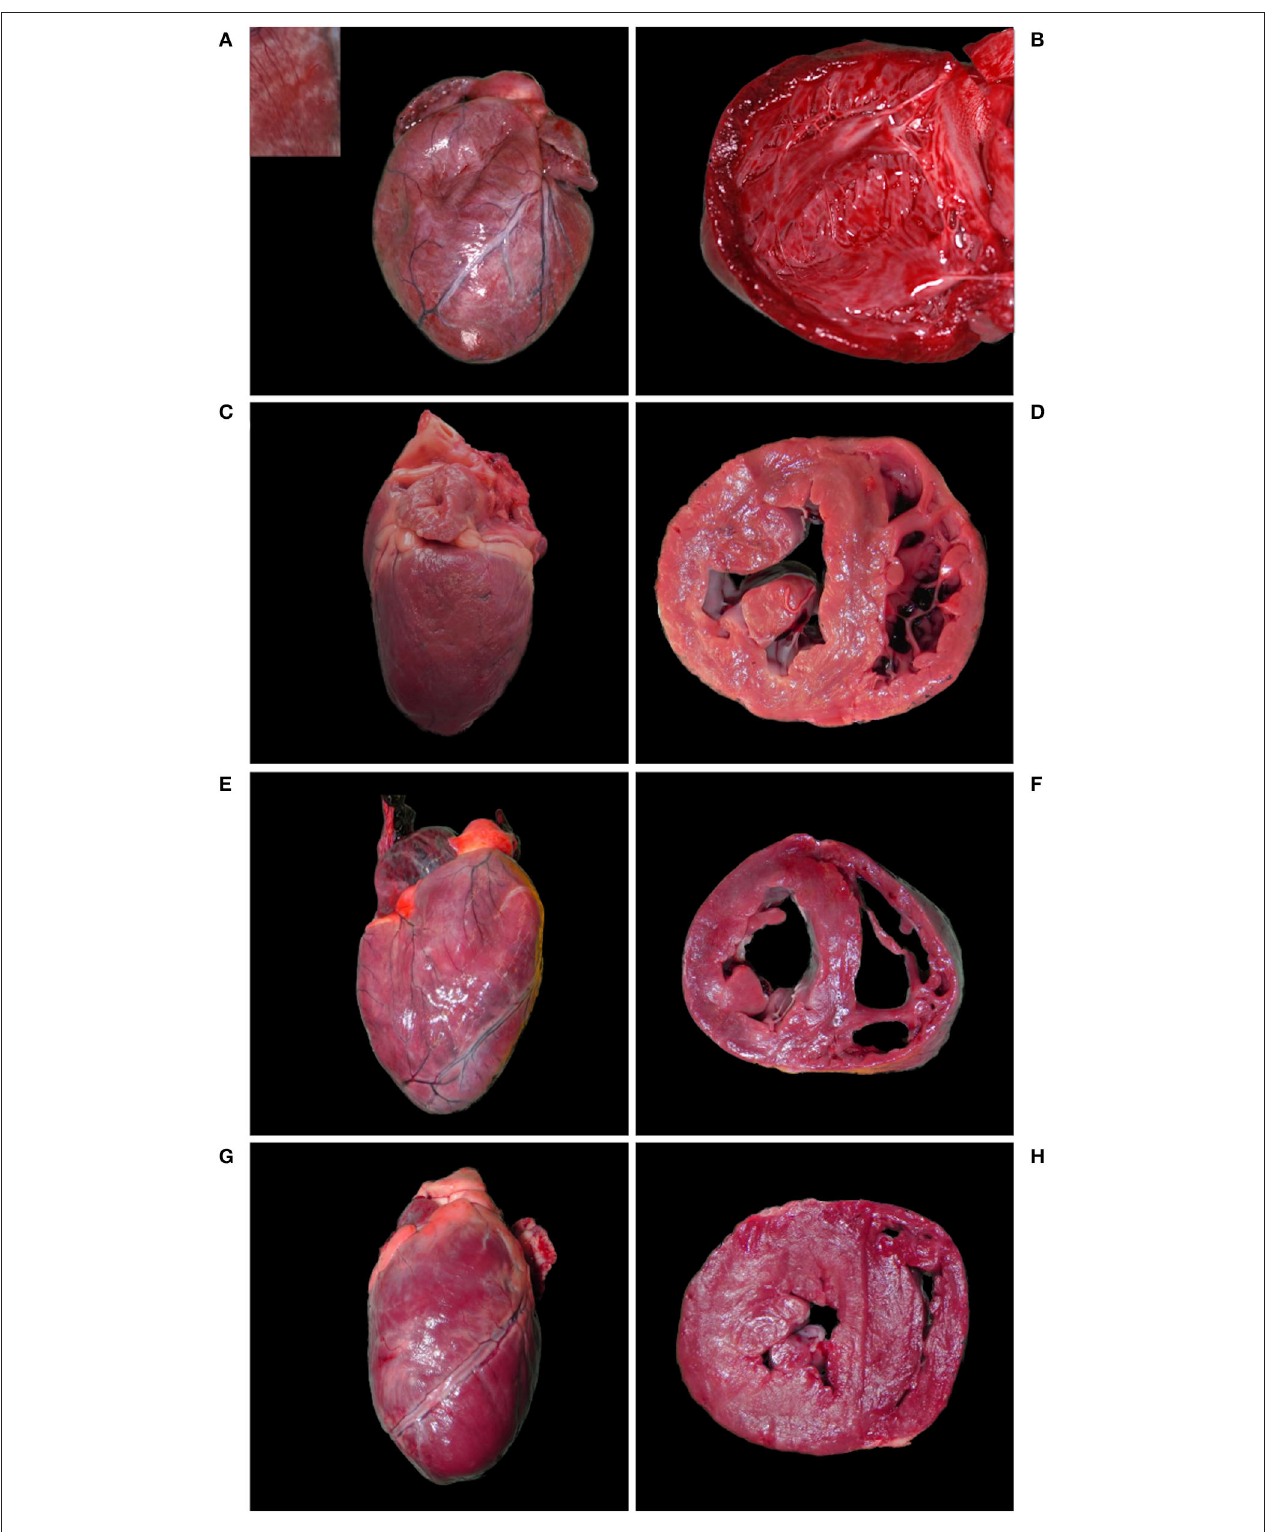
FIGURE 2 | Hearts with cardiomegaly and myocardial fibrosis, Eurasian lynx ( Lynx lynx carpathicus ); (A) case 3, diaphragmatic view: severe cardiomegaly with rounded profile and marked multifocal fine coalescent light tan striations running across the surface (inset) in absence of coronary fat deposits; (B) case 3, left ventricle: severe dilation with attenuation of wall thickness and papillary muscles; (C) case 4, left latero-diaphragmatic view: pale color and moderate cardiomegaly,